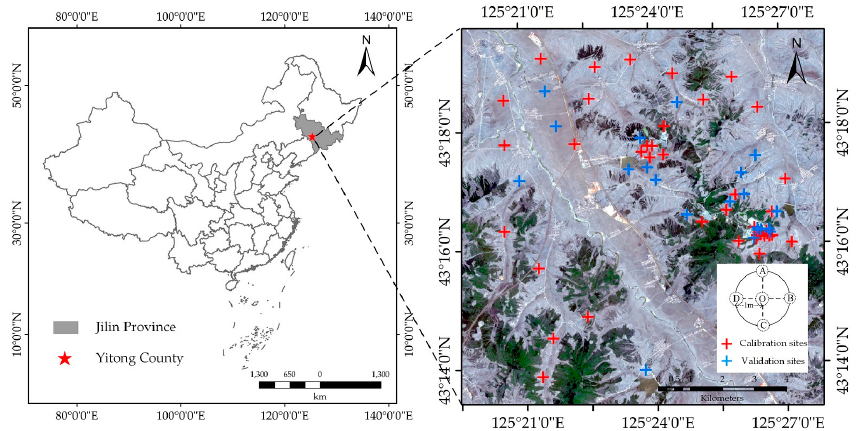
Figure 5. Location of the study area and sampling points. The red and blue points indicate the calibration and verification sites, respectively.